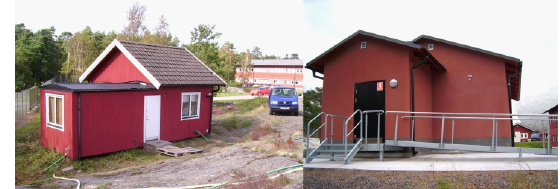
Figure 1: The gravimetry stations at Onsala Space Observatory: (left) the old site (points AS, AN) was occupied by FG5-220 until 2011; (right) the new lab (points AA, AC etc.) has been available since 2009.